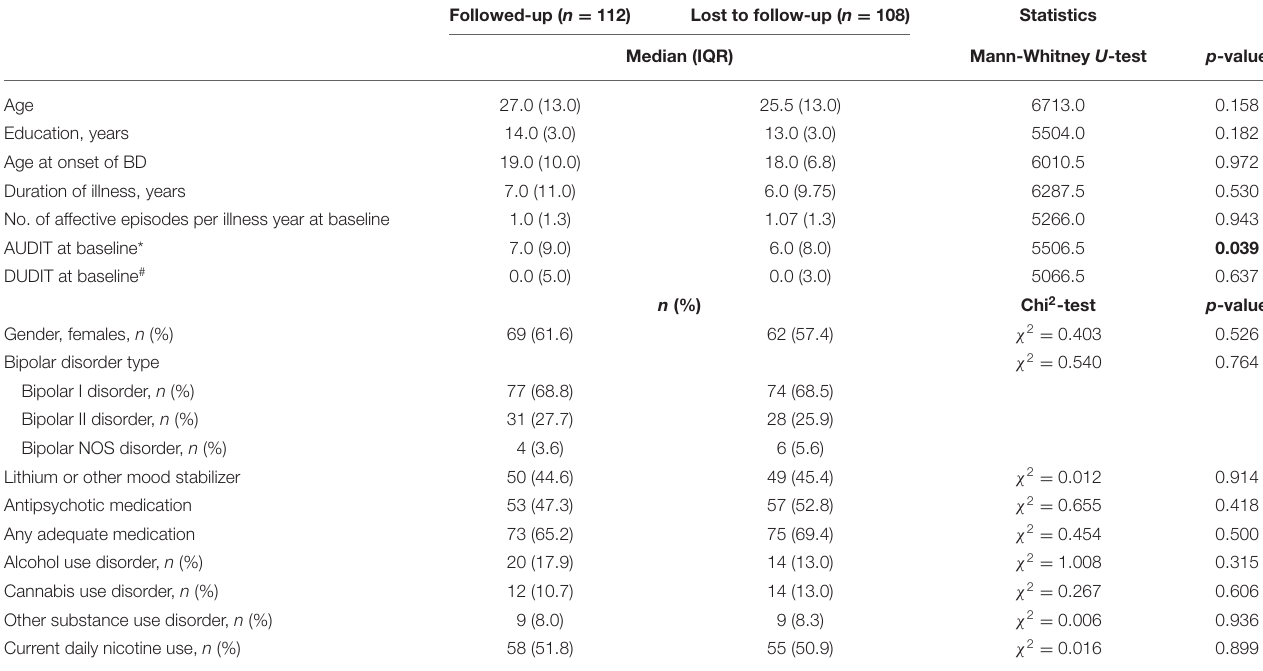
TABLE 1 | Baseline sociodemographic and clinical characteristics of followed-up vs. lost to follow-up sample. Followed-up ( n =